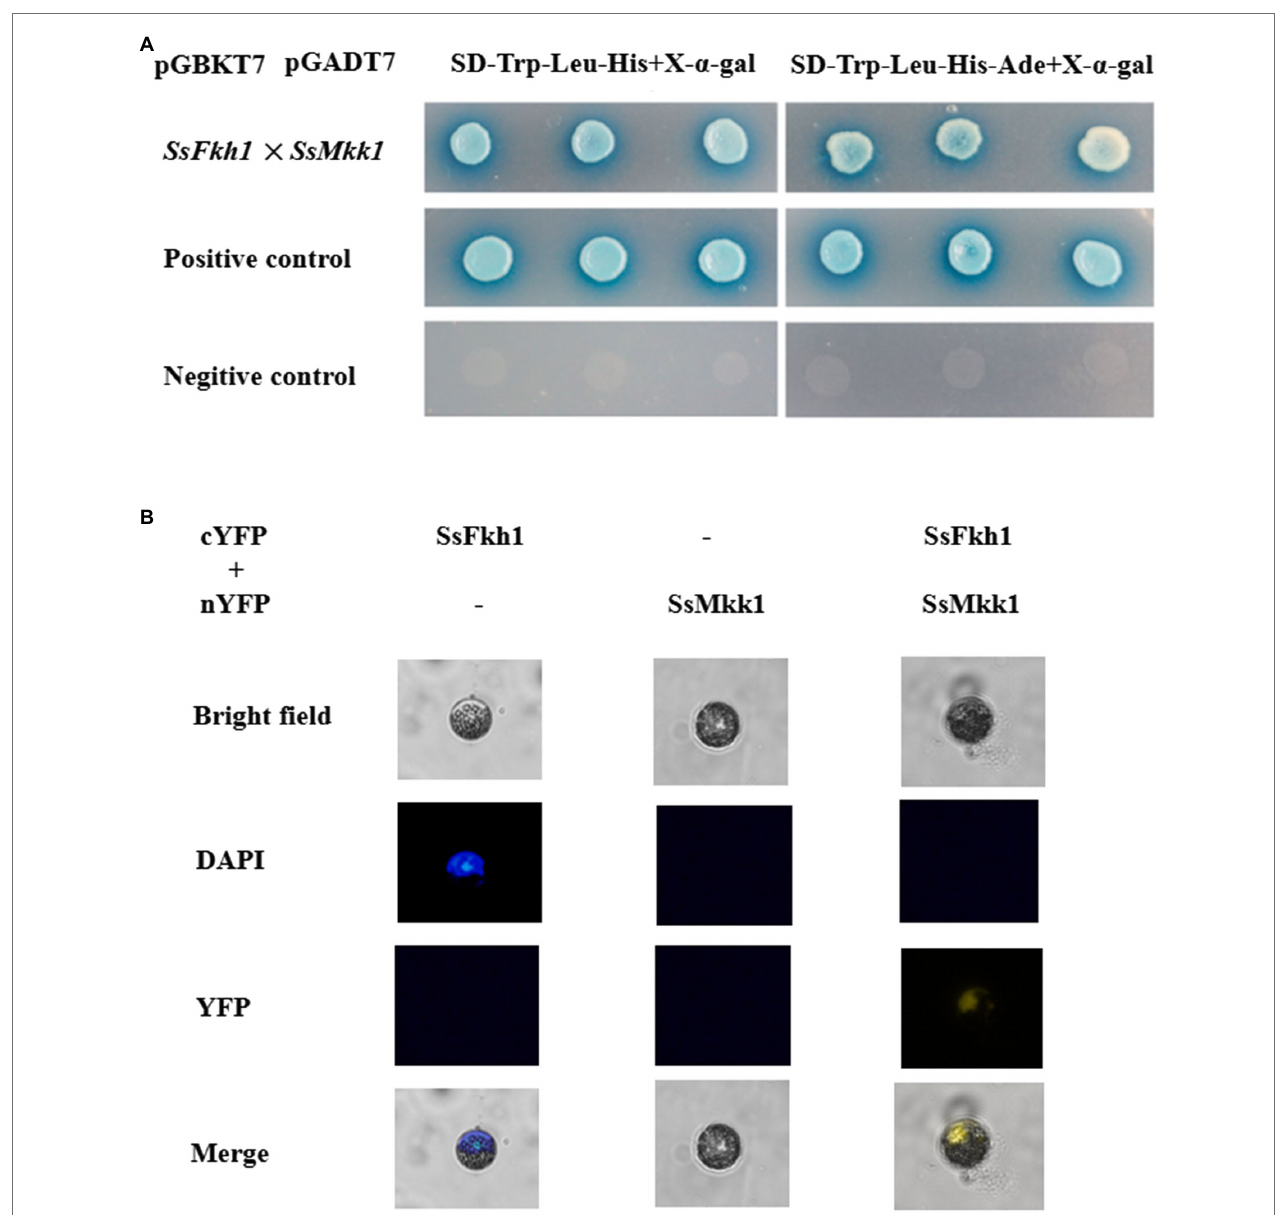
FIGURE 4 | (A) Yeast two-hybrid (Y2H) analysis of interactions of SsFkh1 and SsMkk1. A pair of plasmids pGBKT7-53 and pGADT7 was used as a positive control. A pair of plasmids pGBKT7-Lam and pGADT7 was used as a negative control. (B) Confirmation of the interaction between SsFkh1 and SsMkk1 by bimolecular fluorescence complementation assay (BiFC) in Arabidopsis protoplast. Images were captured under a fluorescence microscope at 13 h after Arabidopsis protoplast transformation. The nucleus was visualized using DAPI (4=,6-diamidino-2-phenylindole) fluorescent dye. cYFP, C-terminal region of YFP; and nYFP, N-terminal region of